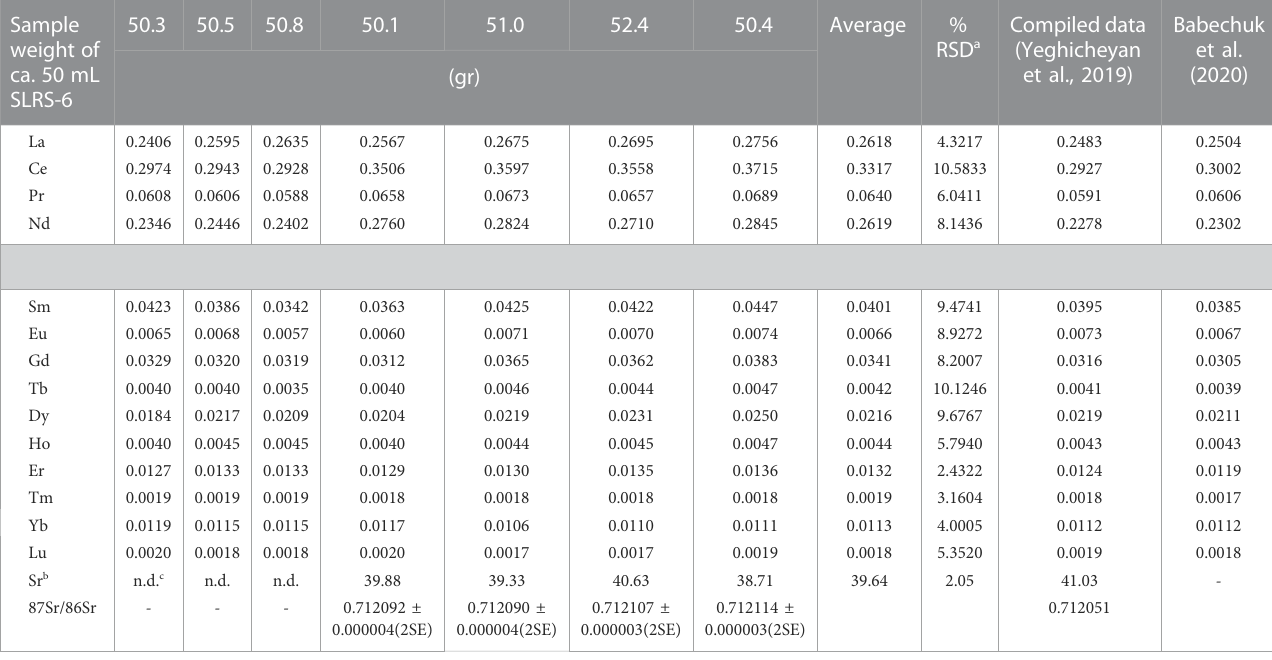
TABLE 5 Concentration ( μ g/L) of rare earth elements in SLRS-6 CRM. Sample weight of